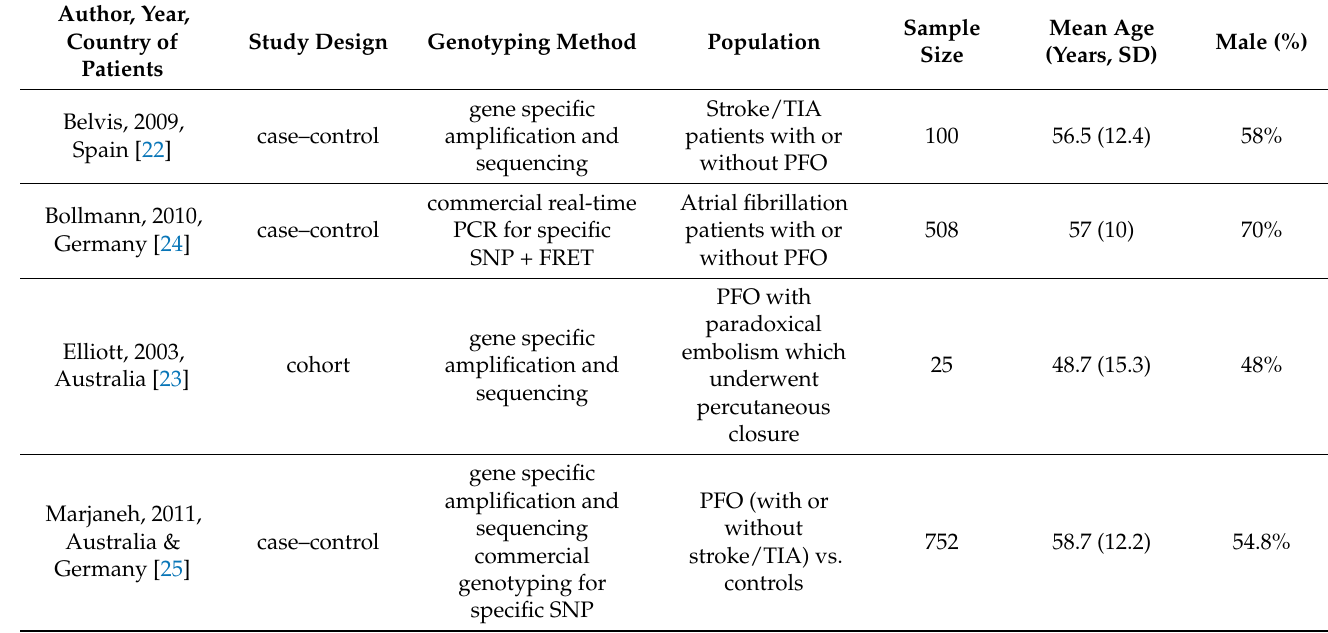
Table 1. Study and patient characteristics of the included studies.